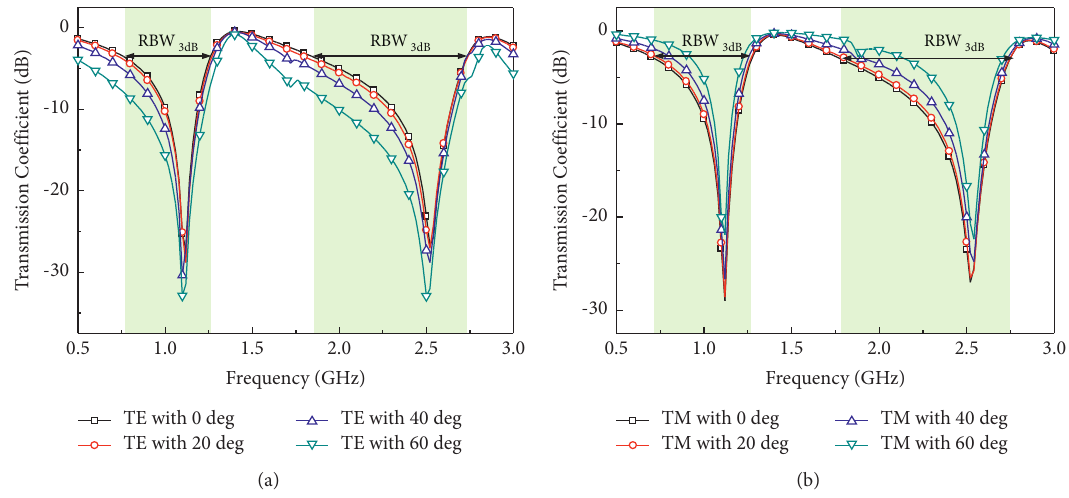
Figure 5: Transmission coefficients of the double-layer FSS with various θ : (a) TE polarization; (b) TM